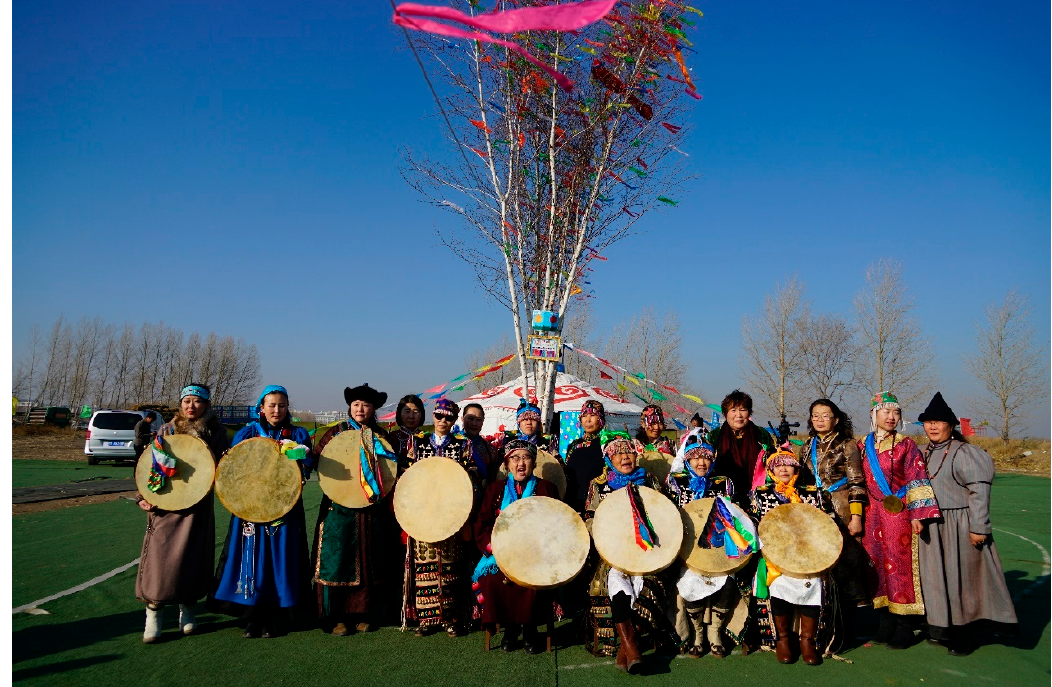
Figure A11. Shaman Siqingua and her disciples: Sitting from the left are: Siqingua, Wo Jufen, Meng Yujin, Wo Liming; Standing from the left are: Enen Duola, Yirugele, Siqin, Gaowa, Ao Zhiwei, Chaolumen Qiqige, Ao Chunmei, Meng Xiaorui, Ao Yuying, Narengerle, Sarina, Jinghua, Subbud. (On 24 October 2017, Meng Yujin’s initiation ritual as jad’ ə n ). Photo: Minna Sa, 2017.